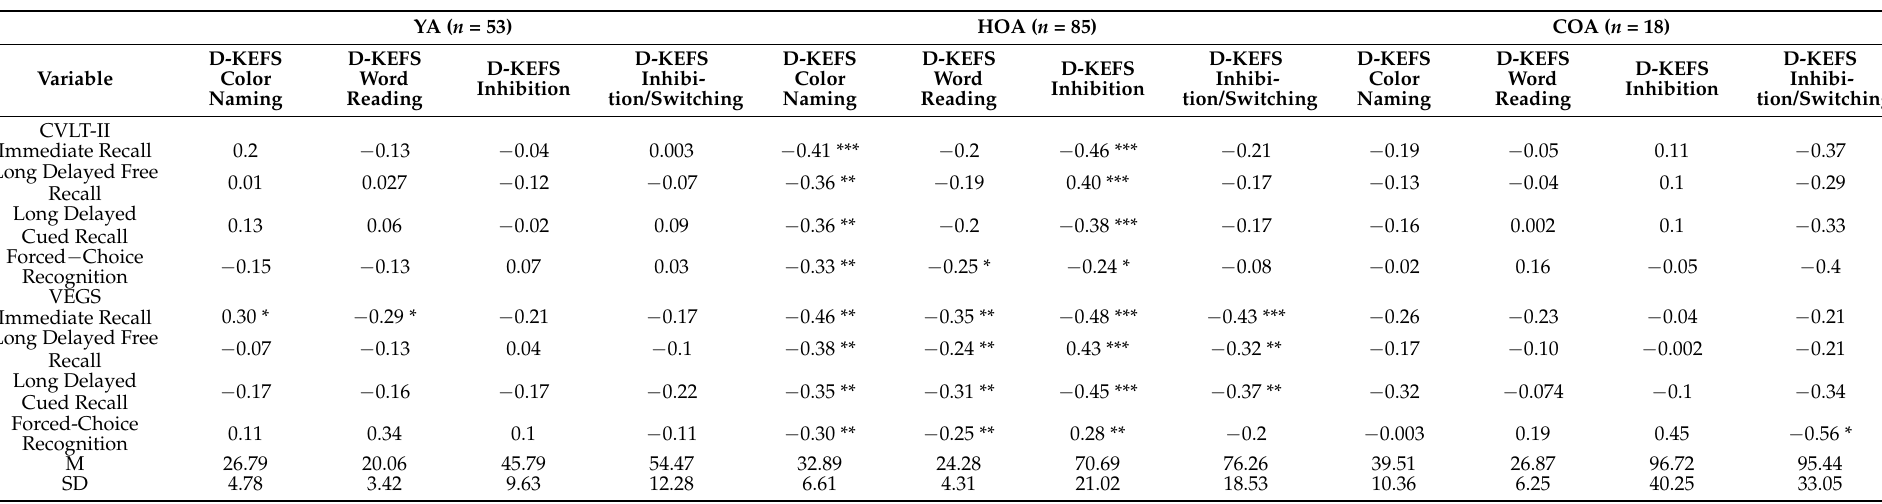
Table 3. Bivariate correlations between variables with descriptive statistics for convergent and divergent validity results for the group memberships ( N =